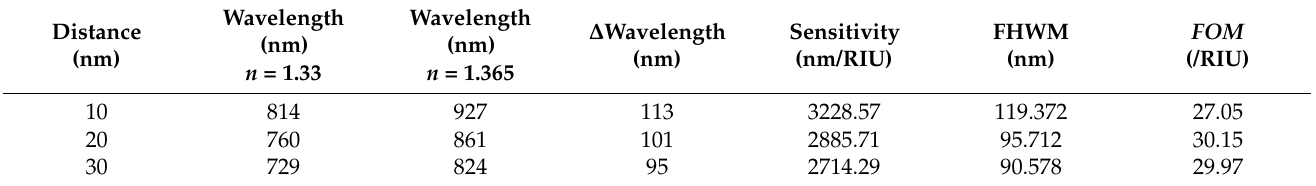
Table 2. Evaluation of the sensing performance for different distances between SiO 2 nanorods.